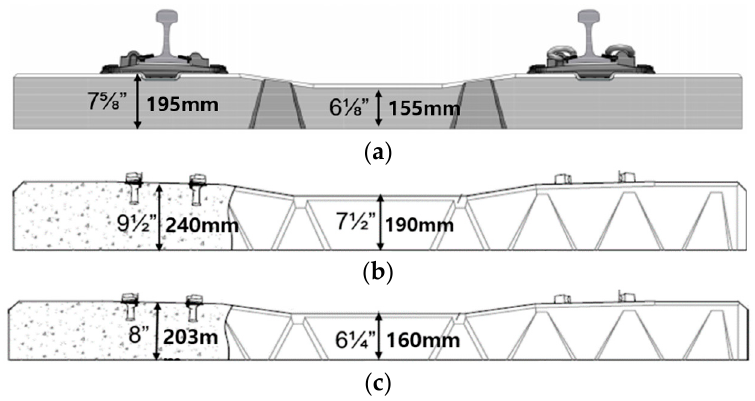
Figure 5. A comparison of ( a ) an EIC sleeper; ( b ) a typical North American freight HAL concrete sleeper; ( c ) a typical North American light rail transit concrete sleeper.